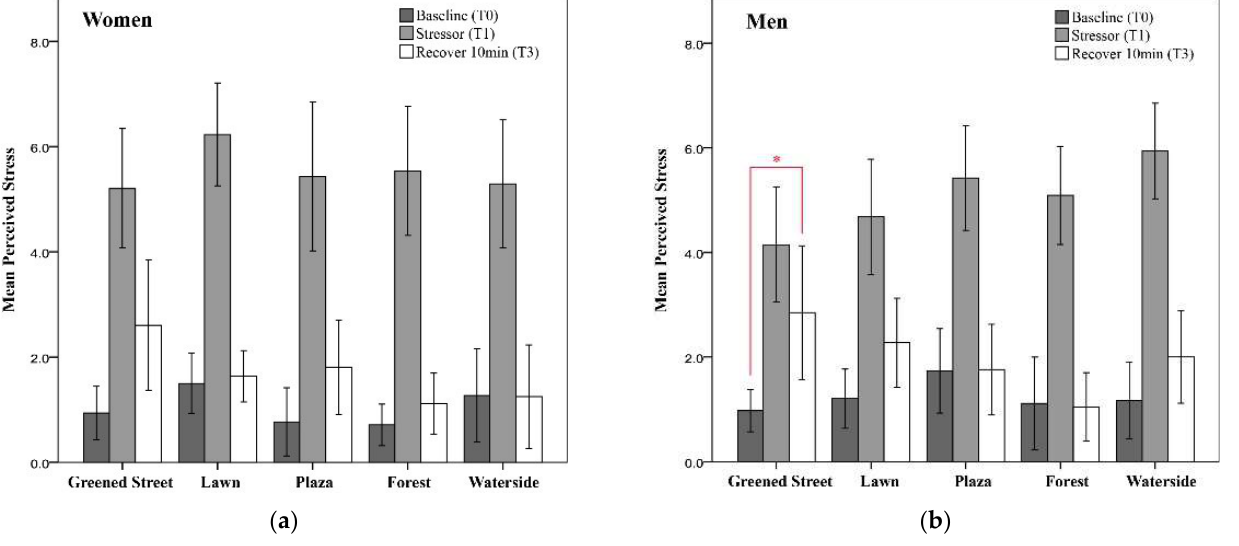
Figure 5. Changes in mean perceived stress (PS) of women ( a ) and men ( b ) in different environments during the recovery phase. Pairwise comparisons between baseline (T0) and end of the recovery (T3) of men in each environmental condition were marked. * p < 0.05.